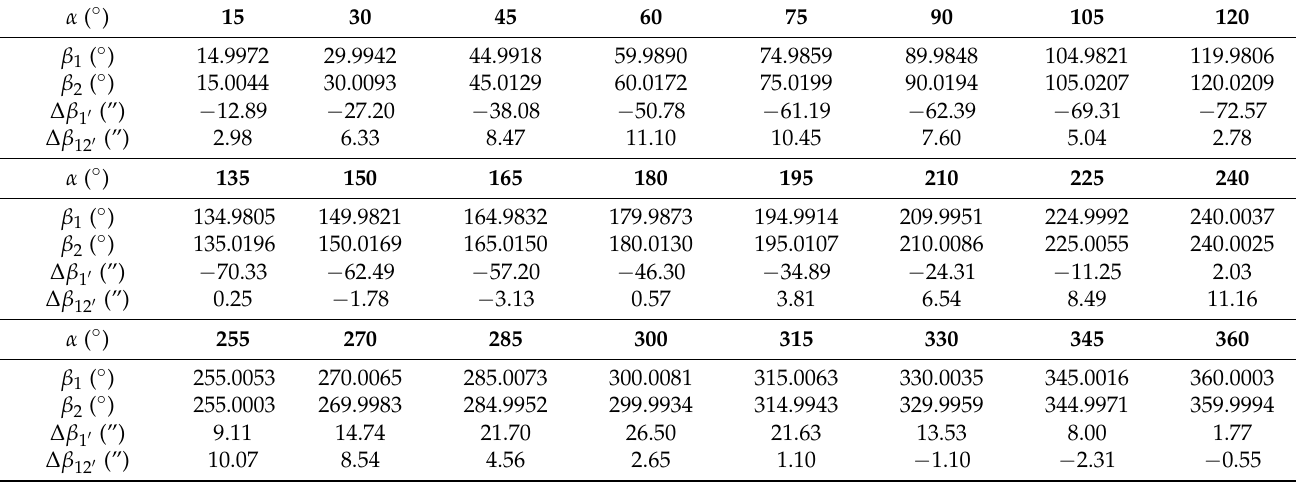
Table 5. The fifth group of angle measurement data and errors.